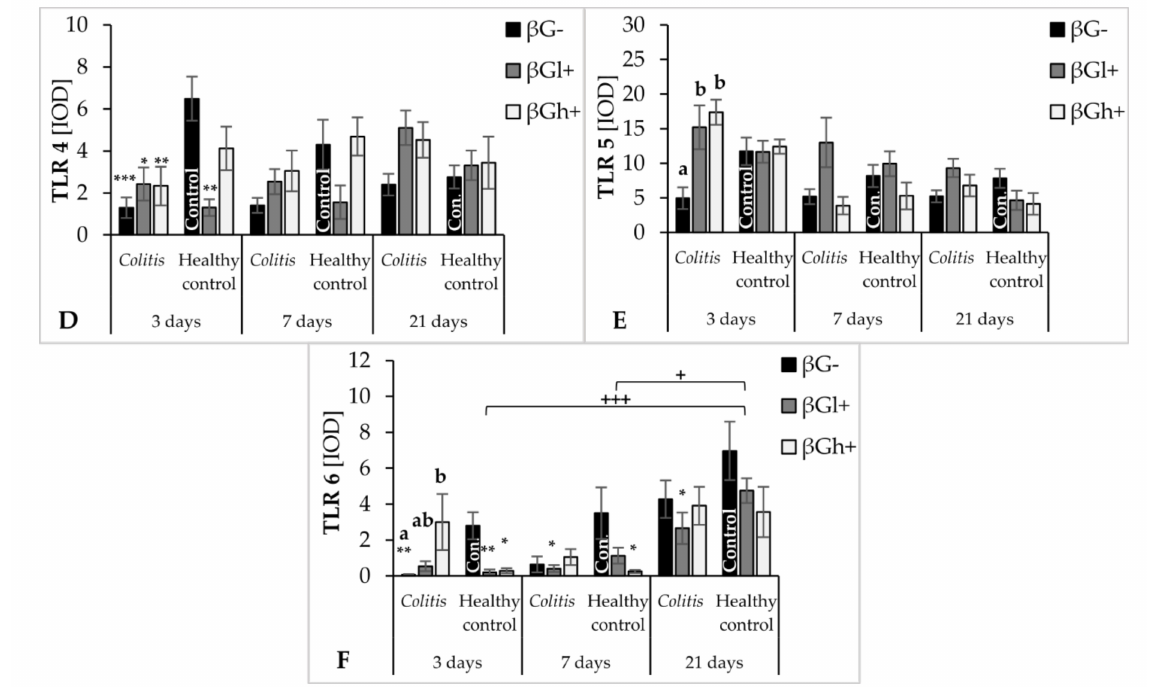
Figure 4. Expression of Toll-like receptors (TLRs) in the colonocytes: results of the immunohistochemical analysis. White arrows indicate colonocytes with high expression of the TLRs (brown precipitate). ( A – C )—Light micrographs imaged under the NIKON Eclipse Ti2 microscope ( × 40 magnification). ( D – F )—Changes in the expression of TLRs (TLR 4, TLR 5, and TLR 6, respectively) presented (mean ± SE) as integrated optical density (IOD). TLR 4 antigen is represented by a brown precipitate in the colonocytes in ( A ). TLR 5 antigen is represented by a brown precipitate in the colonocytes in ( B ). TLR 6 antigen is represented by a brown precipitate in the colonocytes in ( C ). * Significantly different from the control group (healthy control β G − ) at the same time point according to the Dunnett post hoc test (* p < 0.05, ** p < 0.01, *** p < 0.001). + Significantly different from the same subgroups at another time point according to the Tukey post hoc test ( + p < 0.05, +++ p <0.001). a,b Different letters denote significant differences in the colitis /healthy control group at the same time point according to the Tukey post hoc test ( p <